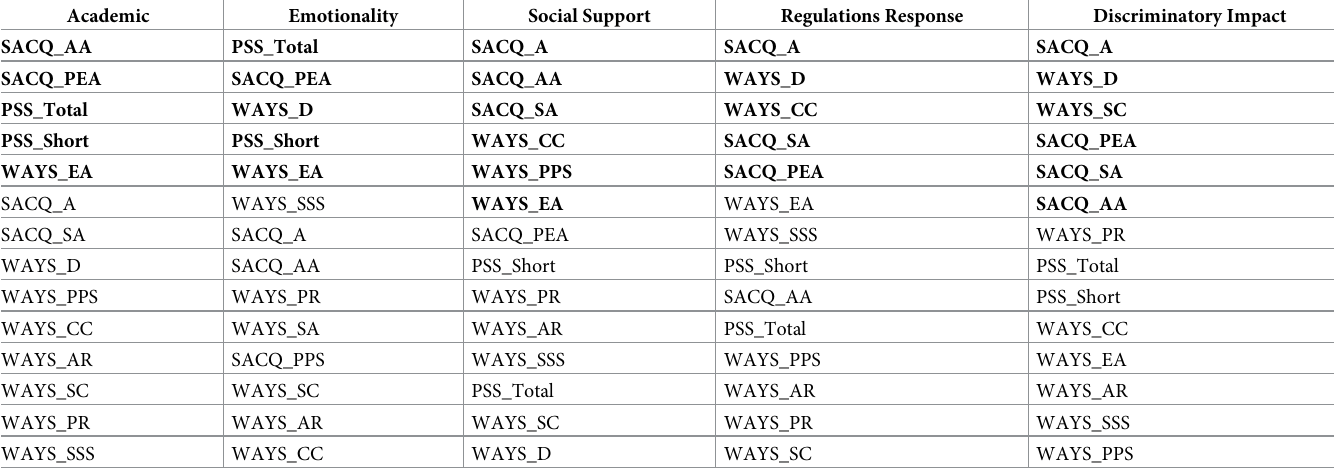
Table 4. Top 10 predictive features for each classification task based on random forest